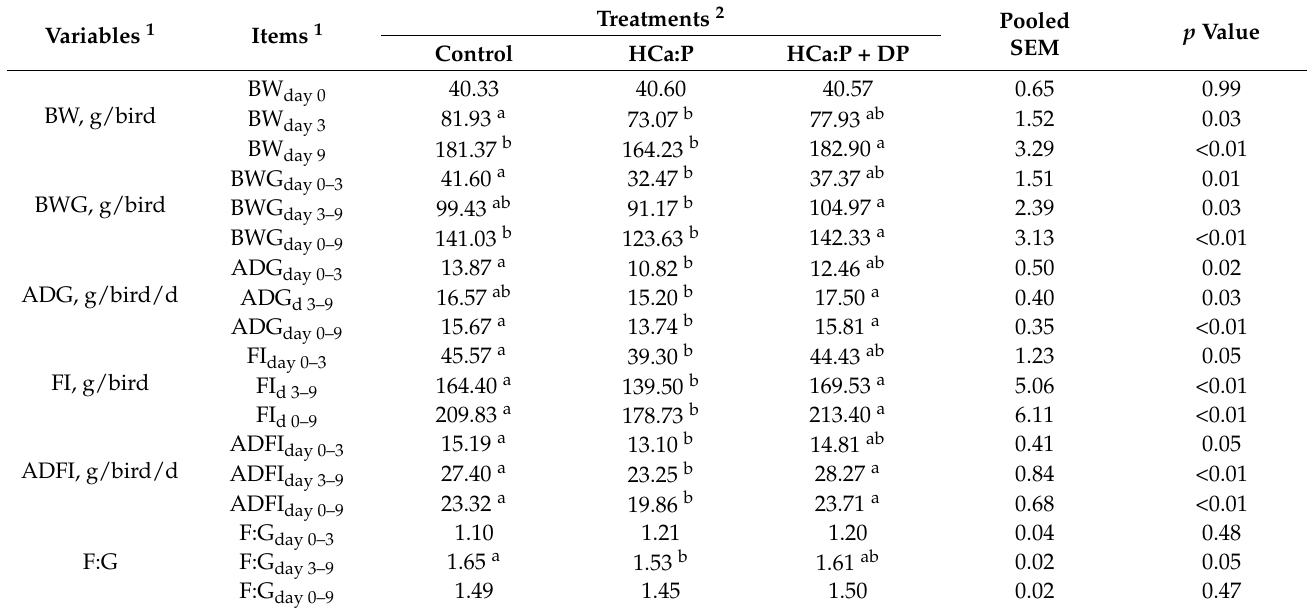
Table 4. Effect of high-calcium (Ca): phosphorus (P) ratio, P-deficient (HCa:P) crumbled feed on growth performance in 0–9 day-old broiler chicks during trial one.